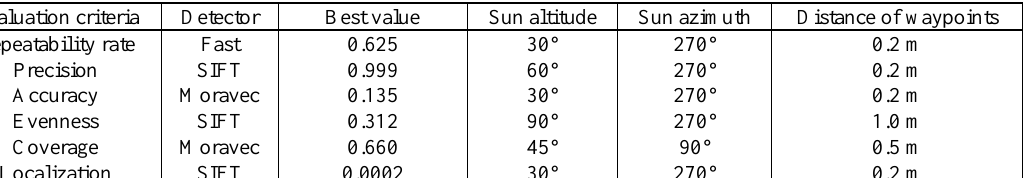
Table 1. List of detectors which provide best result in each